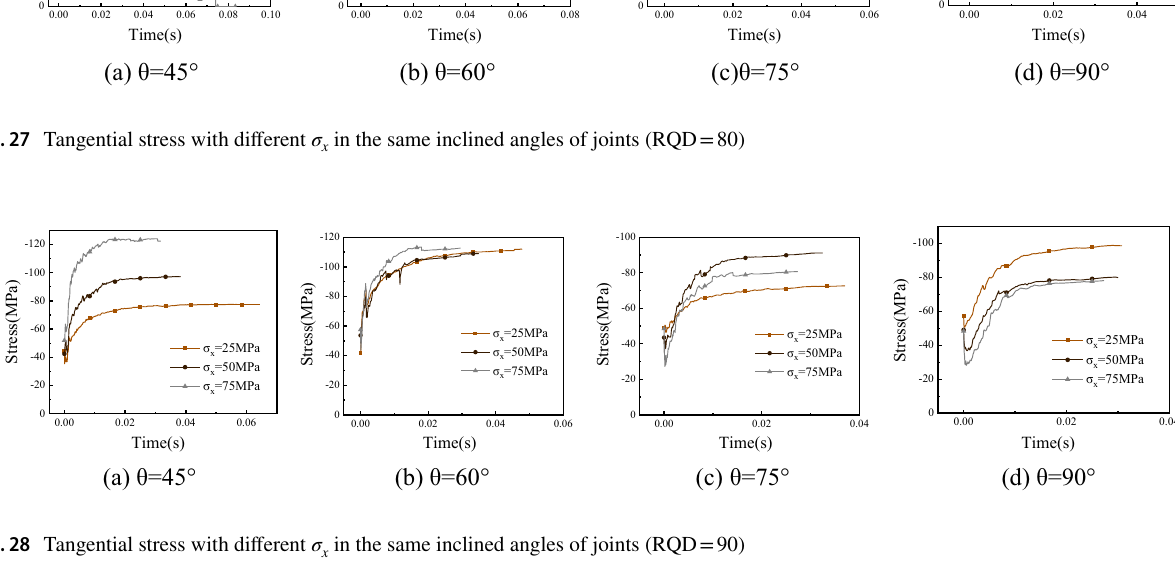
Fig. 28 Tangential stress with different σ x in the same inclined angles of joints (RQD = 90)